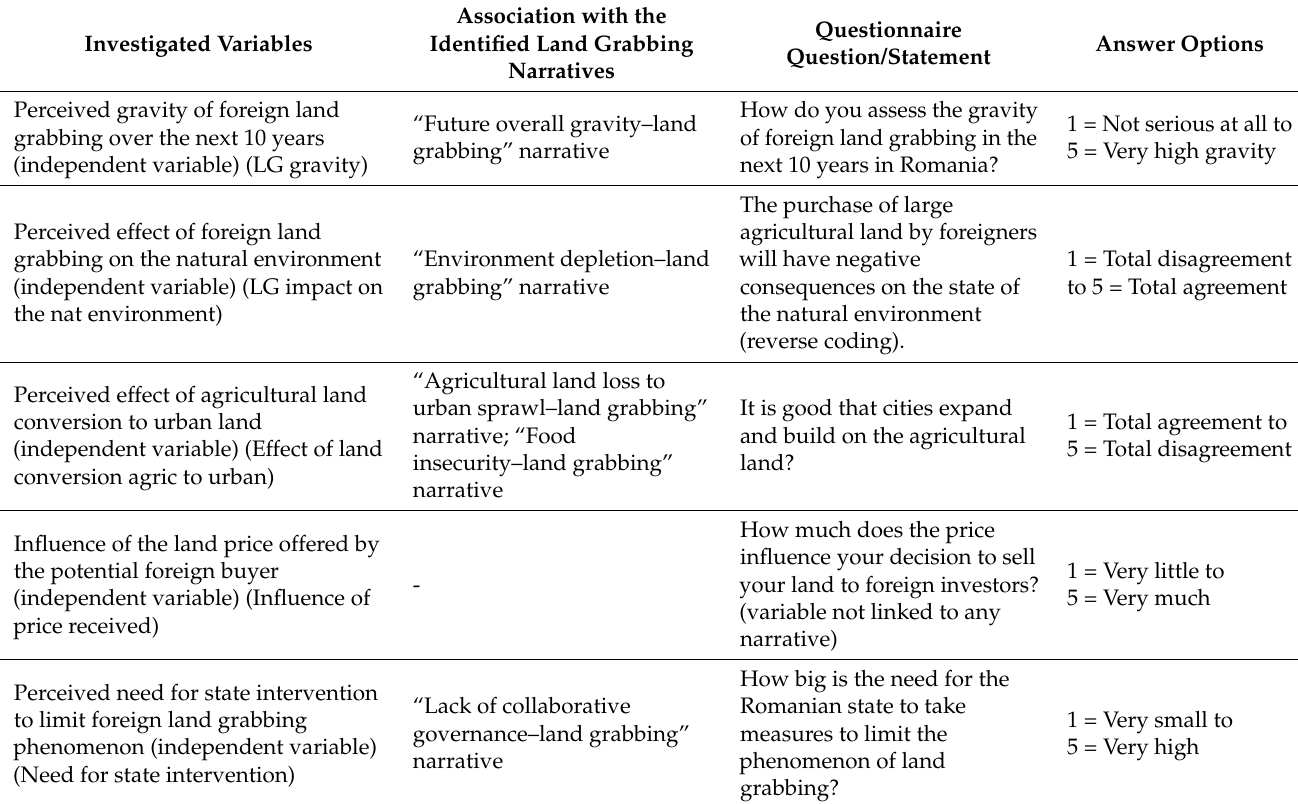
Table 1. Investigated variables (the short name used for each variable in the partial least squares structural equation modeling (PLS-SEM) analysis is written between brackets in the first column).